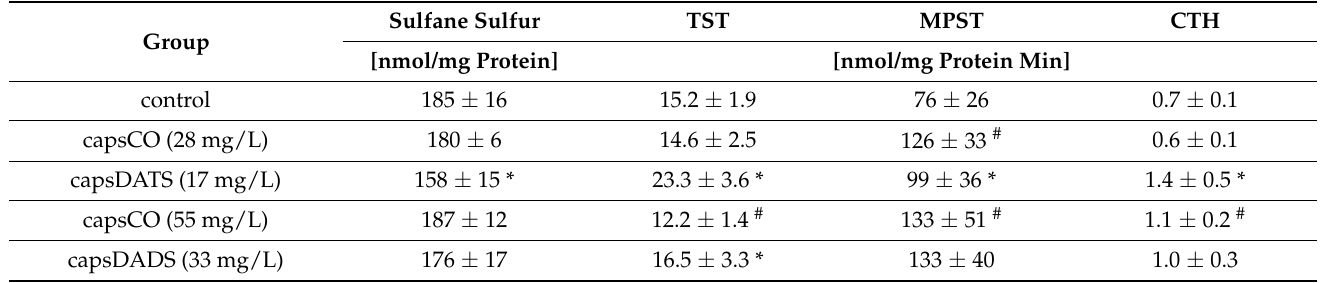
Table 3. The level of sulfane sulfur and sulfurtransferases activity in the 4T1 cell